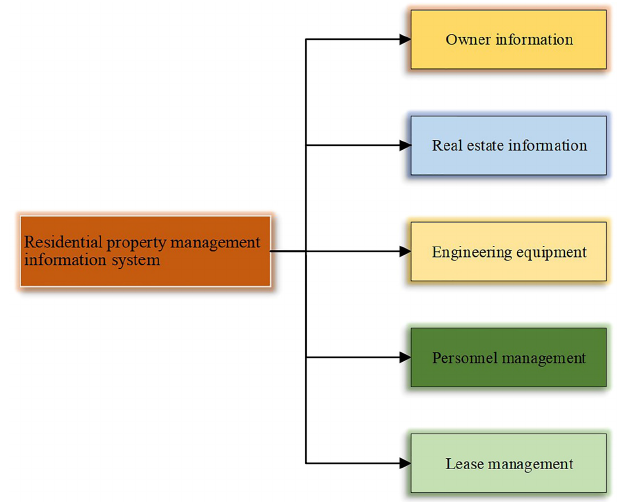
Fig. 2 System function structure